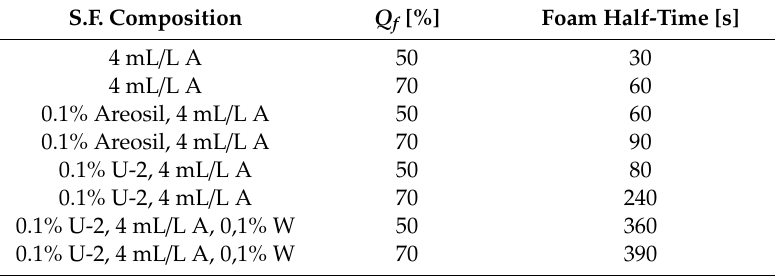
Table 4. Measurements of foamed S.F. half-time with addition of 50% and 70% of N 2